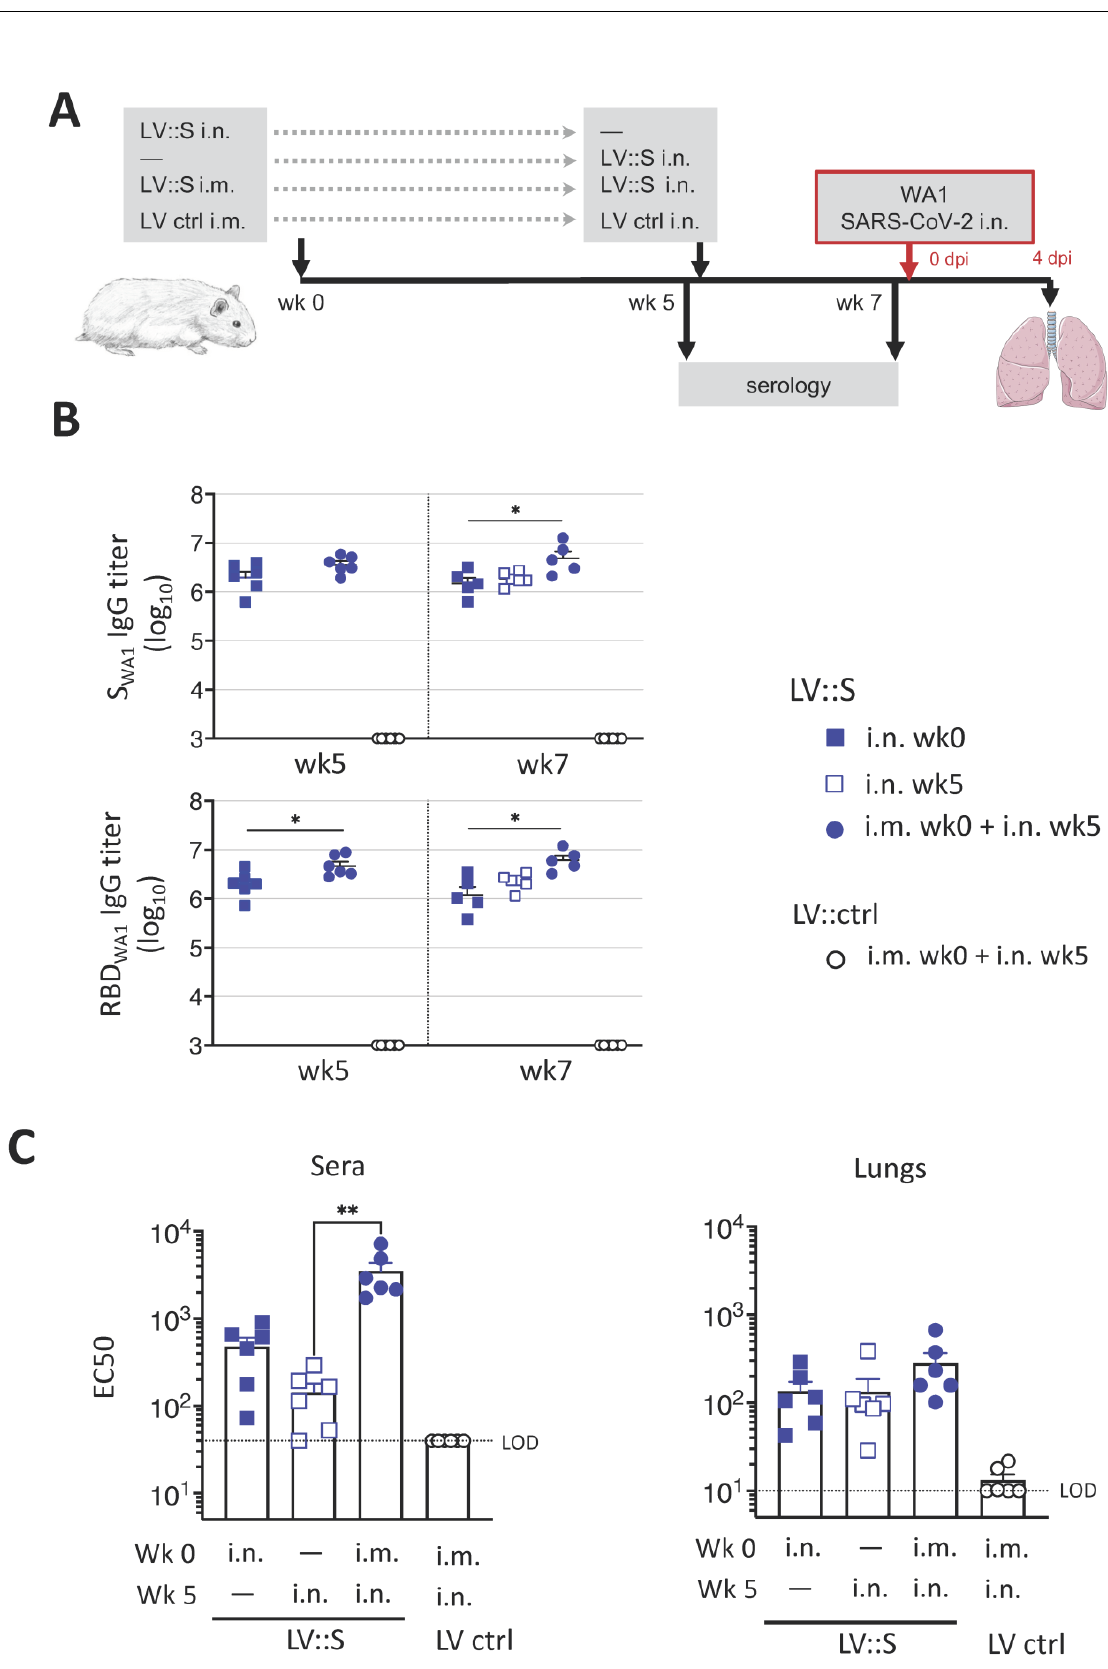
Figure 2. Humoral immunity in hamsters following LV::S administration. ( A ) Timeline of the LV::S prime-boost vaccination regimen and WA1 SARS-CoV-2 challenge in hamsters ( n = 6/group). ( B ) Serum anti-S WA1 or -RBD WA1 IgG responses expressed as the mean endpoint dilution